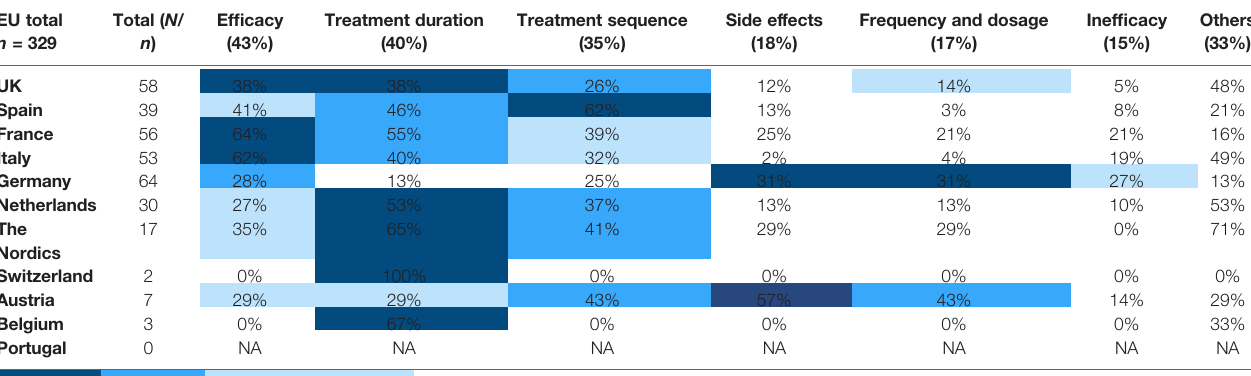
TABLE 5 | Treatment feature topics of